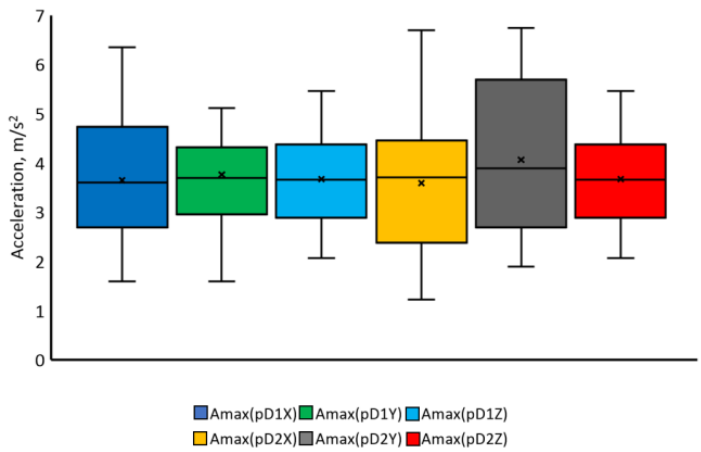
Figure 15. Summary of the values of maximal accelerations obtained in the study of reaching movements in the deceleration phase.